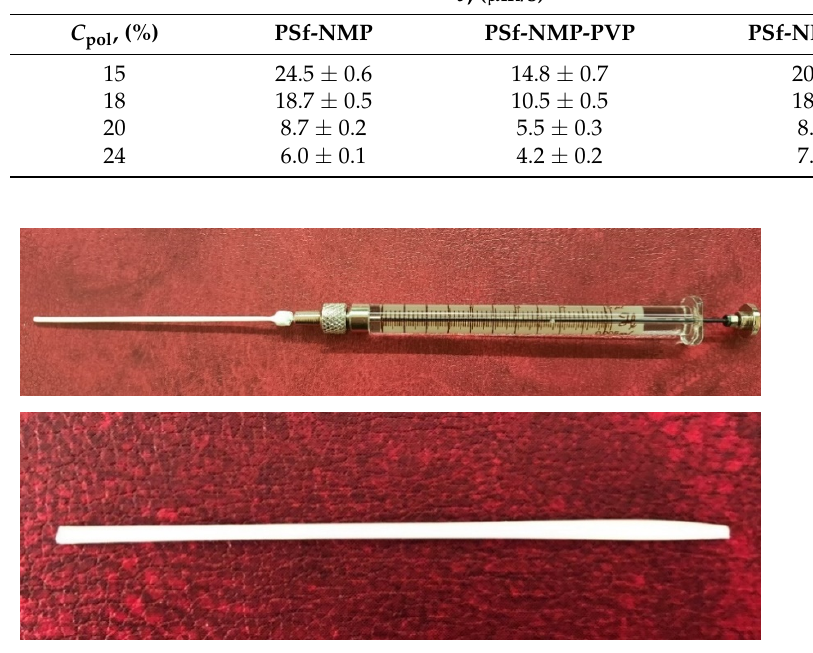
Figure 4. An example of the resulting short-sample of a HF PSf